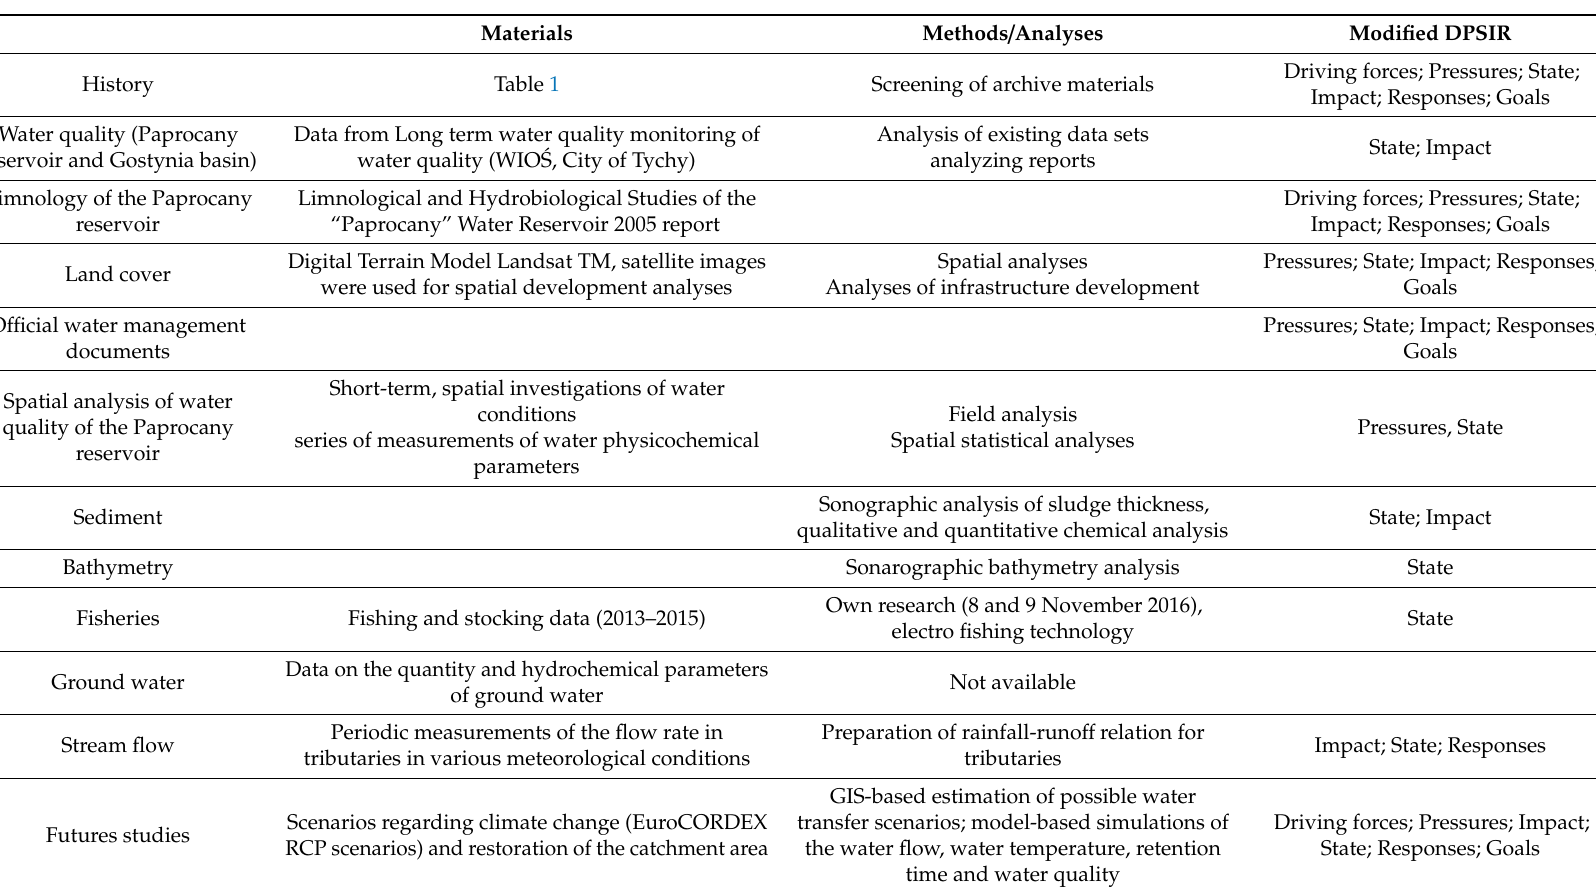
Table 10. Summary of the research materials, and analyses utilized in this study, and their connection to the